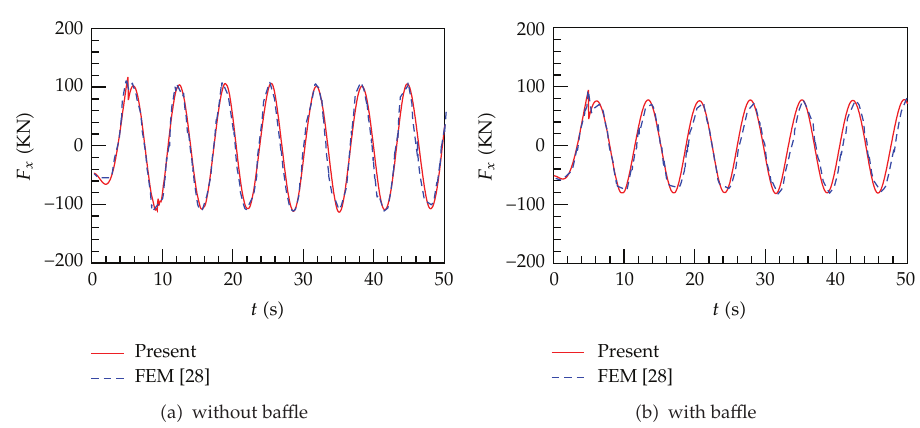
Figure 8: total horizontal hydrodynamic pressure time history with and without vertical ba ffl